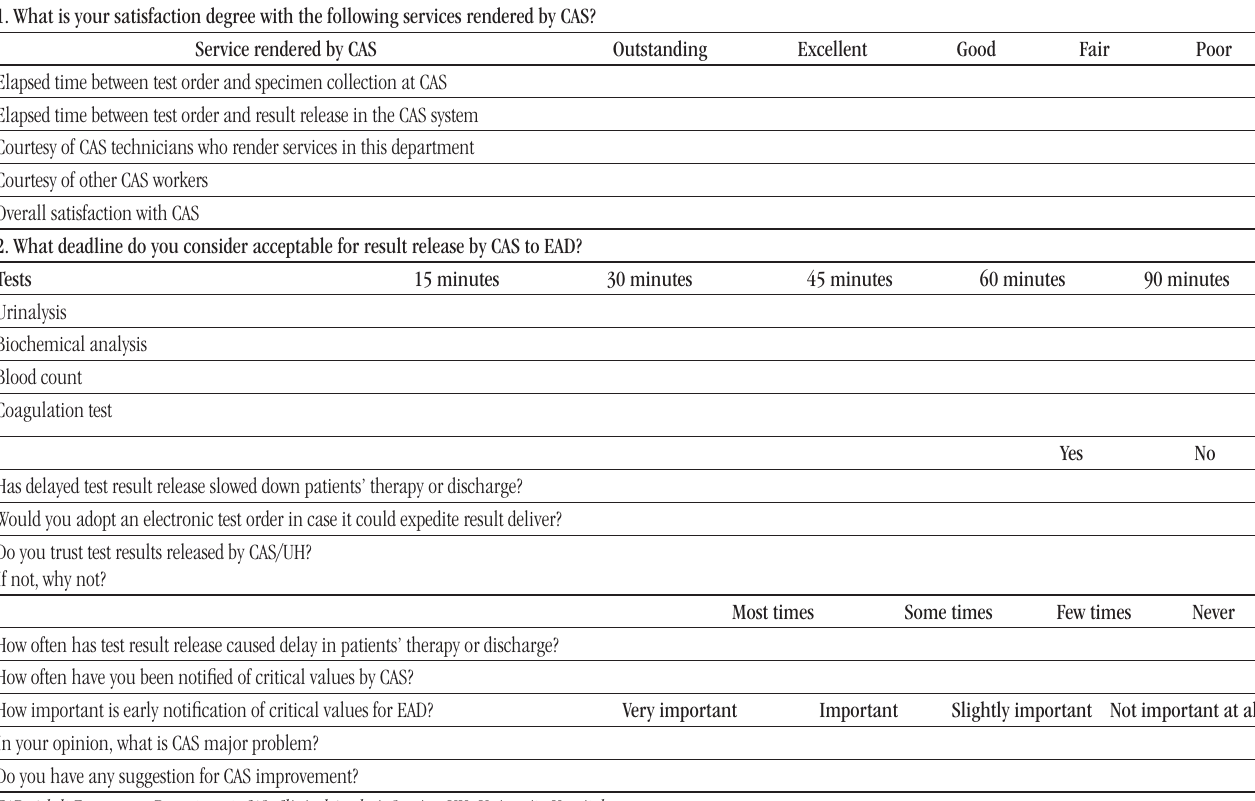
taBLE 1 − Satisfaction questionnaire applied to EAD doctors users of